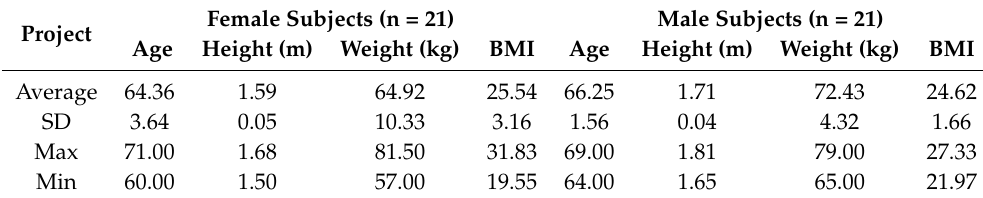
Table 1. Subjects’ basic